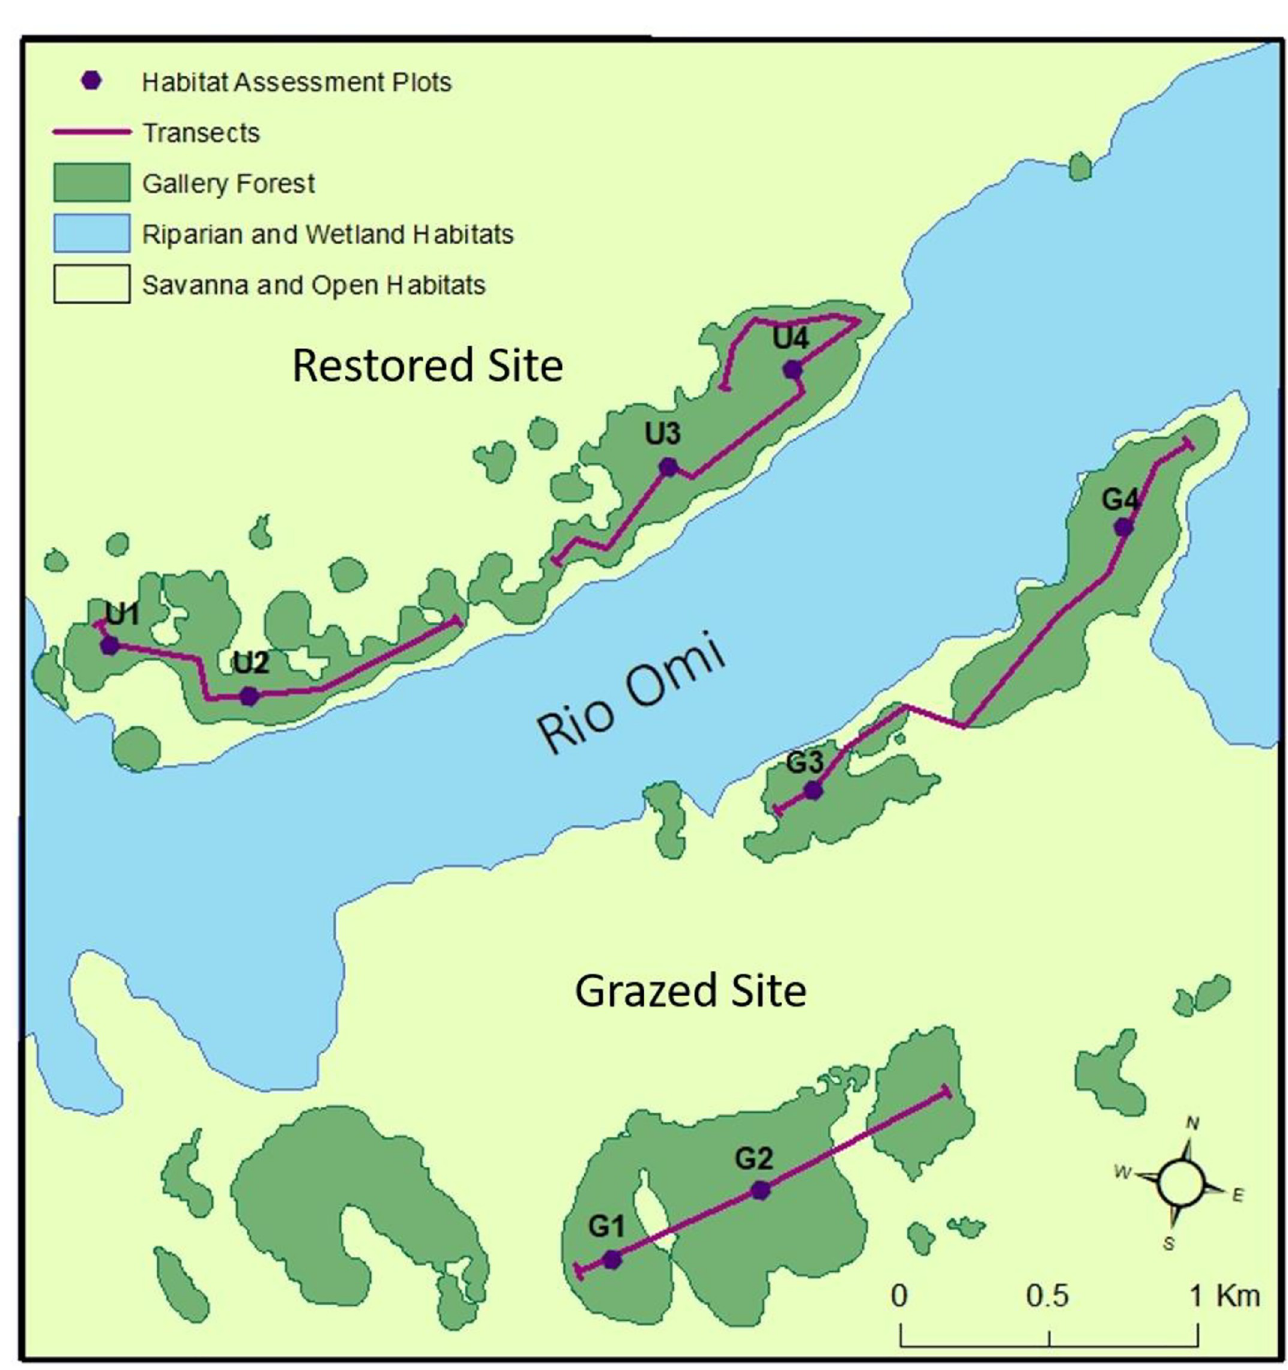
Fig 1. Map of the study area within Barba Azul Nature Reserve, showing the main sections of gallery forest within the restored and grazed sites (north and south of the Rio Omi respectively), and the locations of habitat assessment plots and wildlife line transects.